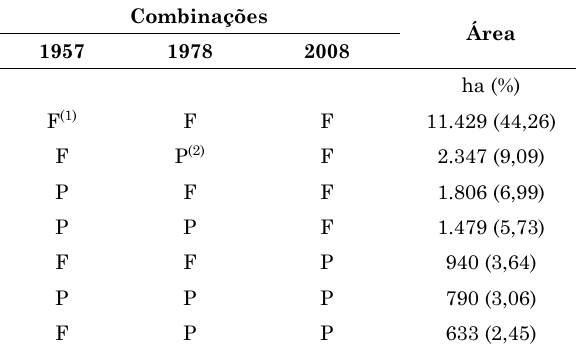
Quadro 1. Diferentes formas de uso ou cobertura vegetal nos períodos estudados, com as respectivas áreas